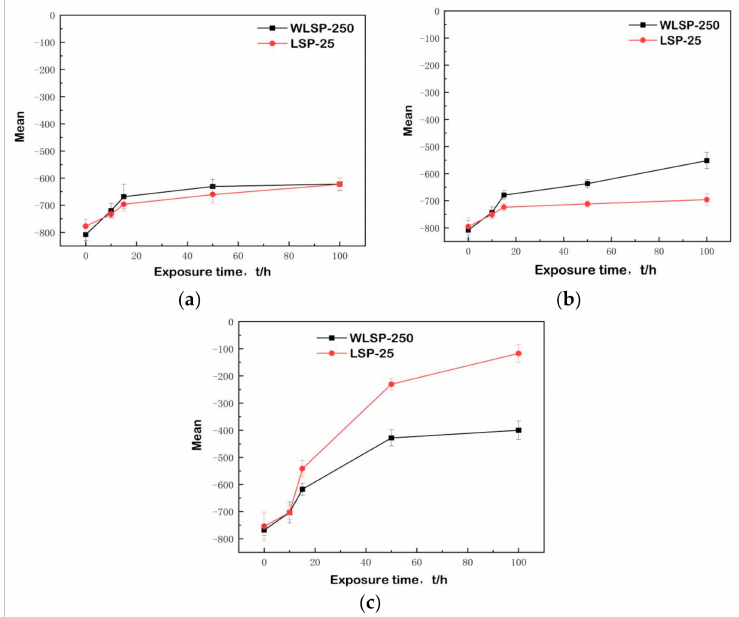
Figure 5. Surface residual stress via exposure time at di ff erent temperatures: ( a ) 250 ◦ C, 3 J, 4 times, spot overlap rate of 50%, aging process at 600 ◦ C; ( b ) 250 ◦ C, 3 J, 4 times, spot overlap rate of 50%, aging process at 650 ◦ C; ( c ) 250 ◦ C, 3 J, 4 times, spot overlap rate of 50%, aging process at 700 ◦